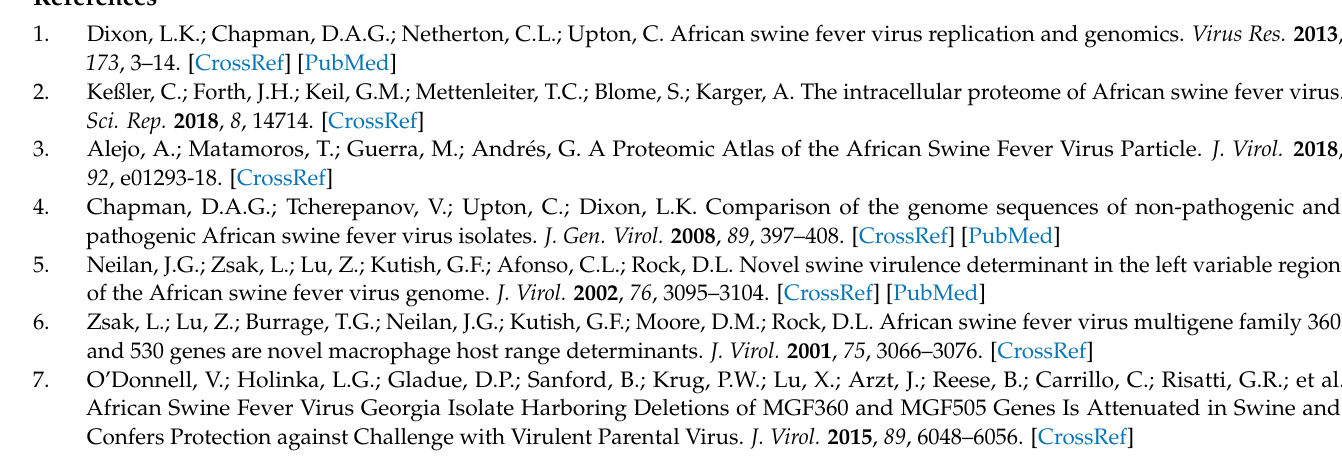
cytometry, Figure S2: confirmation of ASFV infection in MS samples, Figure S3: expression levels of viral proteins in individual replicates, Figure S4: volcano plots comparing expression levels of host genes under different conditions, Figure S5: detected peptides and distribution of ASFV-polyproteins ASFV-CP530R (pp62) and ASFV-CP2475L (pp220), Figure S6: peptide spectra of ASFV genes K196R and MGF 505-3R, Table S1: antibodies used for flow-cytometry, Table S2: relative standard deviations of host and viral proteins between sample groups, Table S3: results of Wilcoxon ranked test for differ- ential expression of genes belonging to functional groups or kinetic classes in moM Φ or WSL